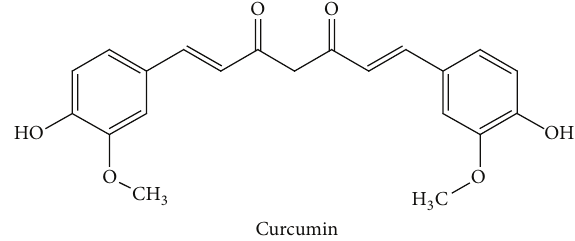
Figure 7: Chemical structure of